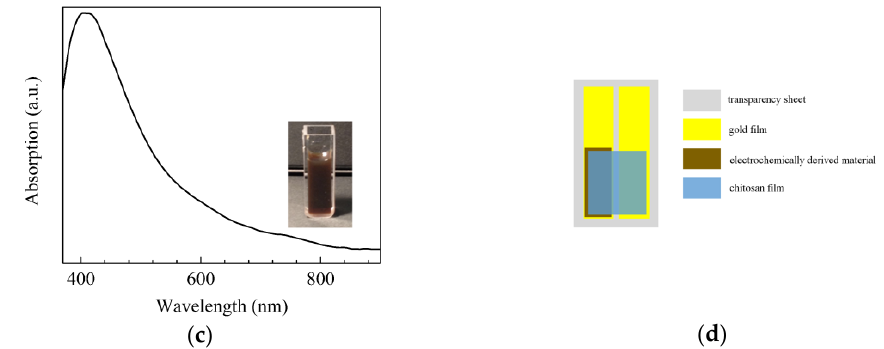
Figure 1. Absorption spectrum of the chitosan aqueous solution ( a ); photo and absorption spectrum of the green ( b ), and of the brown ( c ) materials electrochemically derived from copper wire electrodes immersed in chitosan solutions; ( d ) schematic view of the solid state cells based on chitosan.